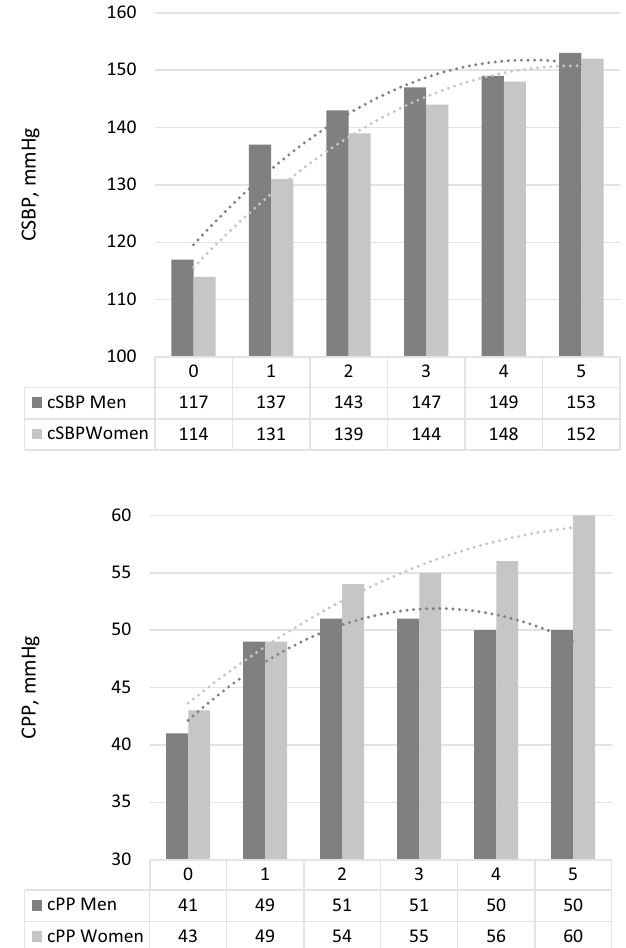
Figure 1. Central systolic blood pressure and pulse pressure values according to the number of altered MetS components. Men—black bars, women—gray bars. Numbers from 0 to 5 indicate the numbers of MetS components. Significant sex-specific differences in CSBP (p < 0.001) and in CPP (p < 0.001). Three components or more are considered typical of